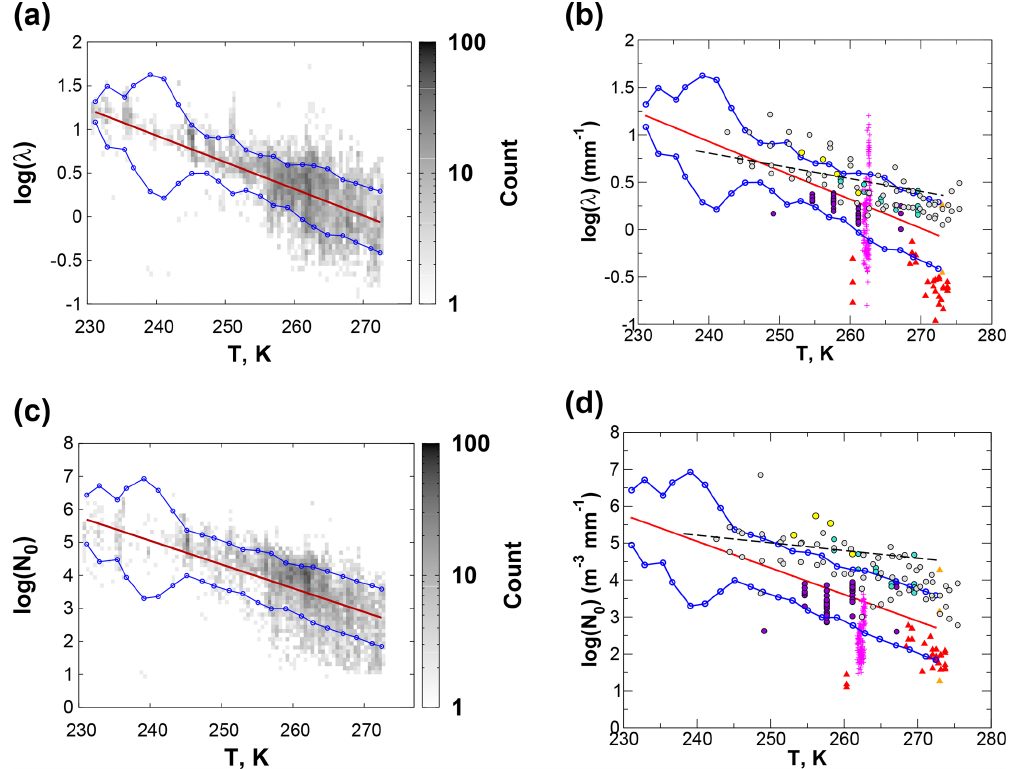
Figure 2. Dependence of log (λ) and log (N 0 ) on temperature. Central red lines show the best-fit relationships, while the upper and lower blue lines show bounds given by ± 1 residual standard deviation. The shaded gray shows the 2D histogram of values for the C3VP surface and aircraft observations ( a and c ). Symbols ( b and d ) match those from Fig. 1 except that, in lieu of symbols for Woods et al. (2008), the dashed black line shows a linear best fit reported by the